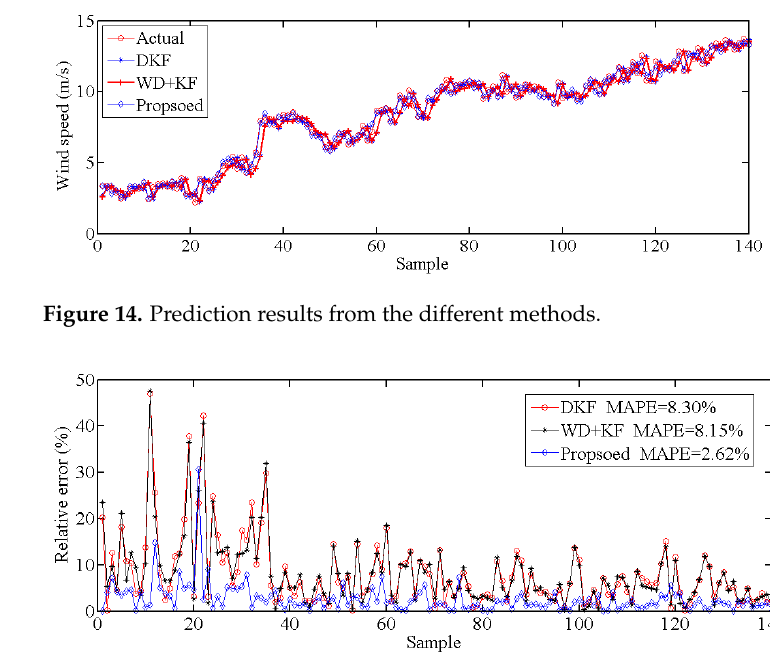
Figure 15. Prediction errors from the different methods.